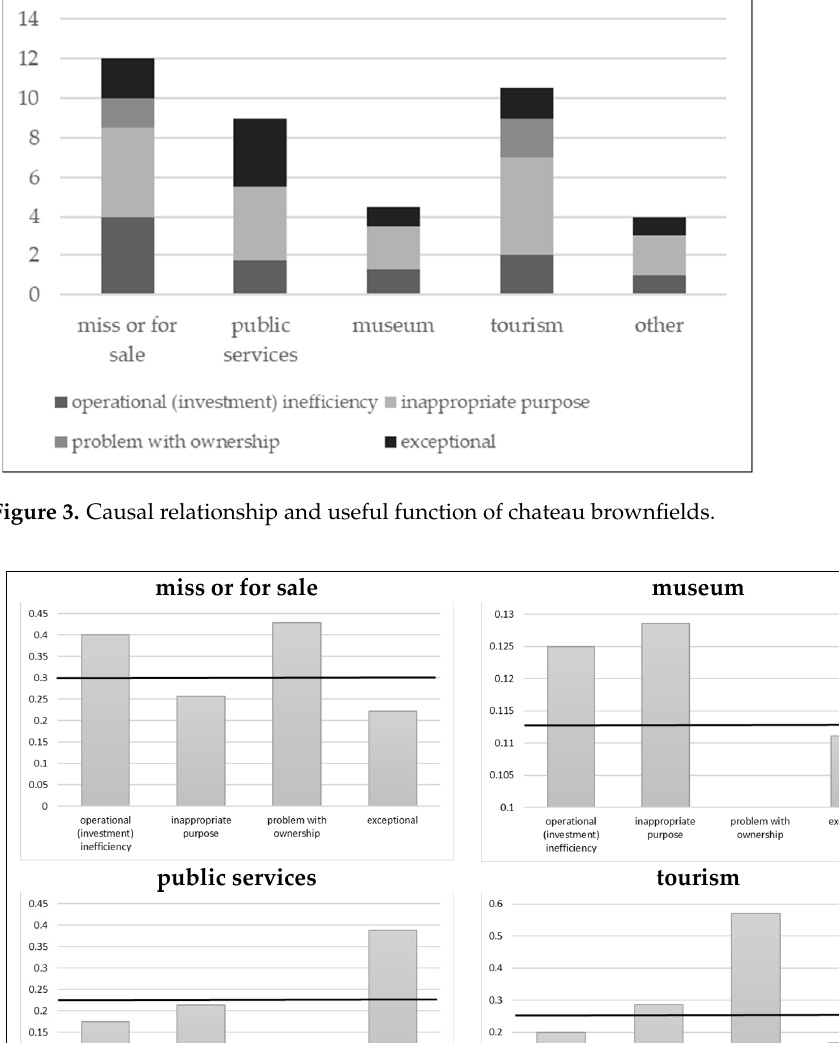
Figure 4. Selected causal relationship and useful function of chateau brownfields supplemented with an average value.